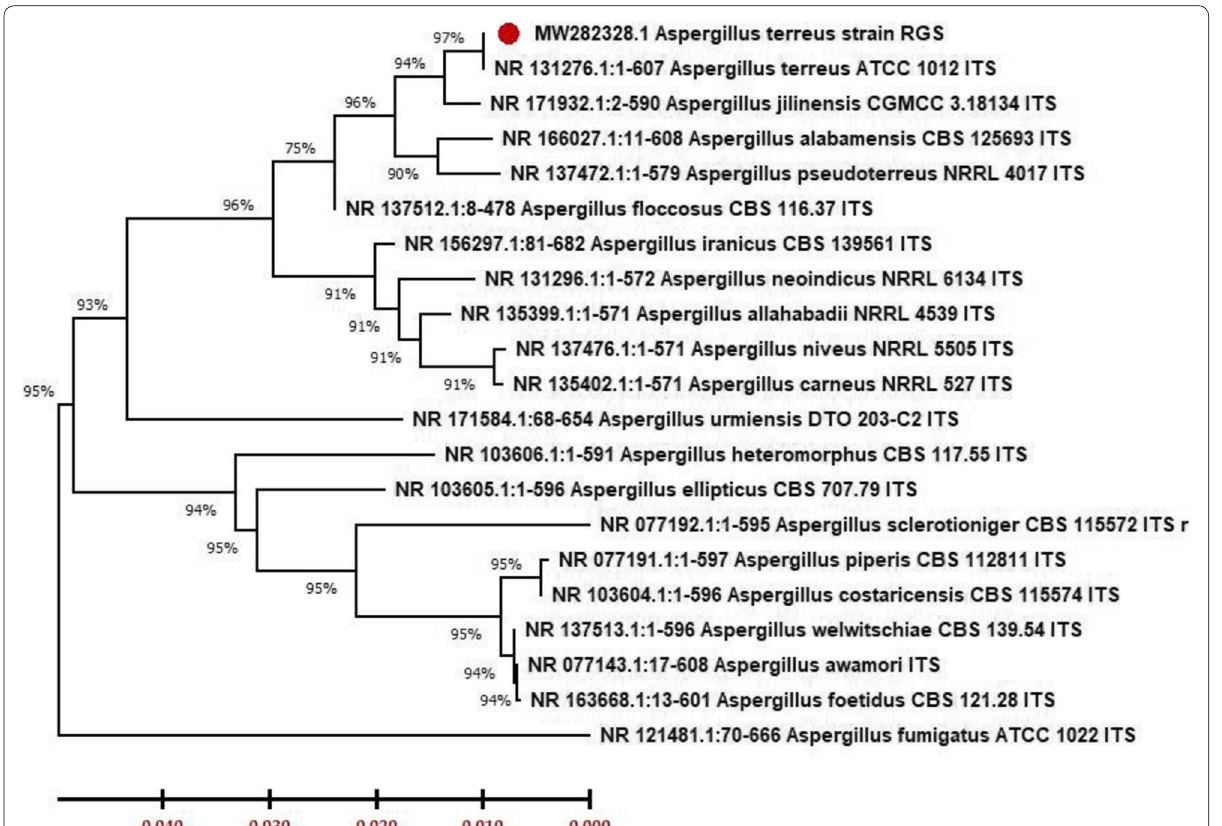
Fig. 2 Phylogenetic tree of A. terreus strain RGS. Eg‑NRC was inferred using the neighbor‑joining method (MEGA X). The numbers on the nodes indicating the percent of bootstrap value